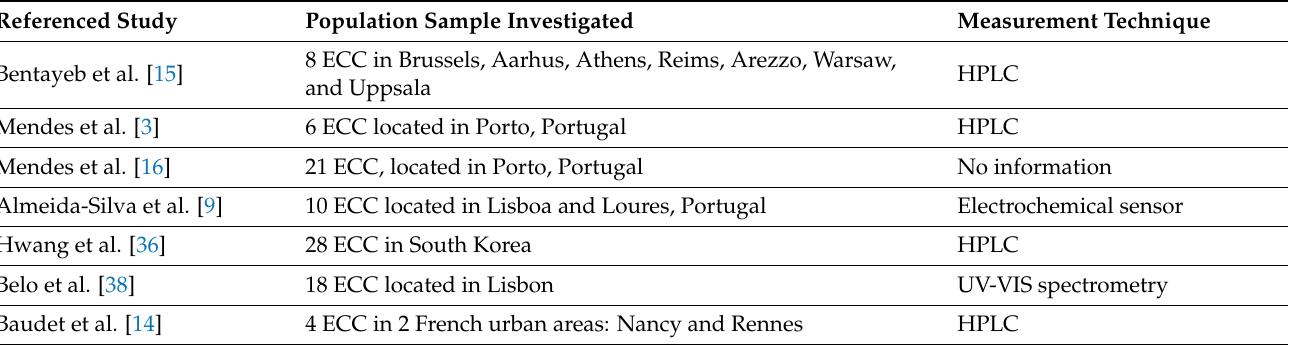
Table 2. Formaldehyde measurements conducted in Elderly Centers